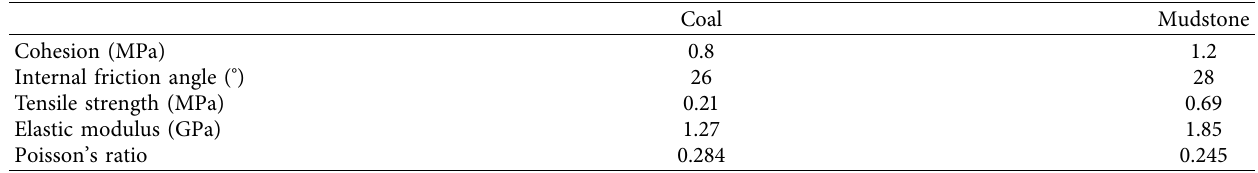
Table 4: Mechanical parameters of coal and mudstone.